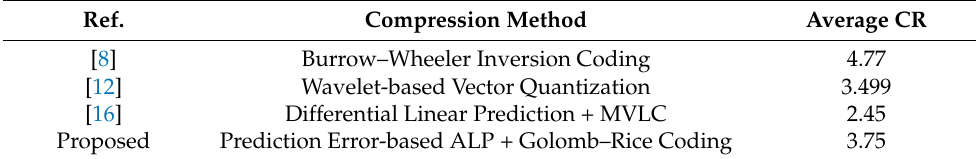
Table 2. The comparison of the average compression ratio to other methods on EDB data set. Ref.